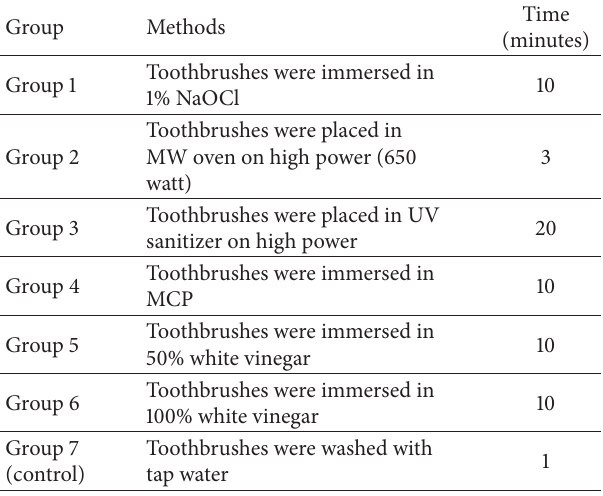
Table 1: The methods of disinfection examined in this